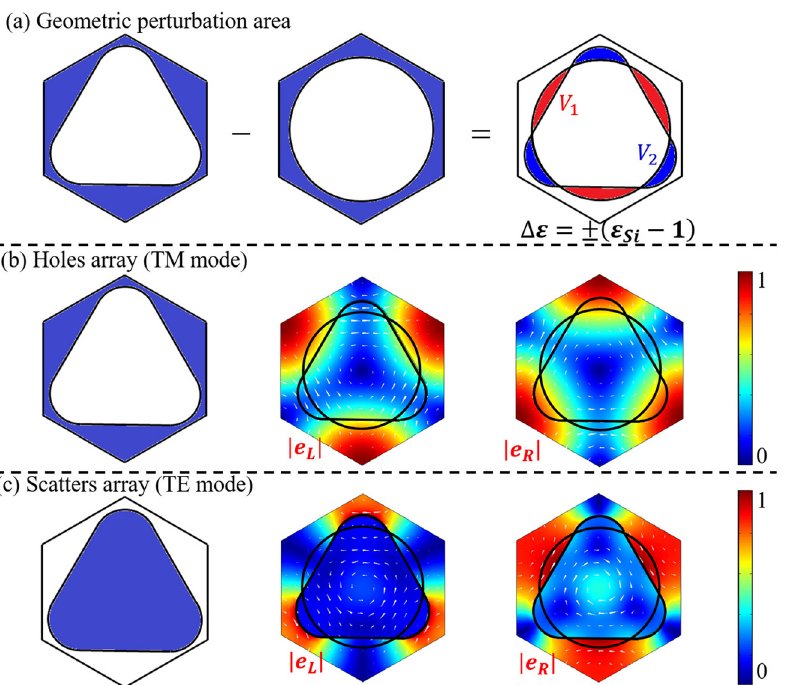
− 1 ) is Si 1 ( K ) is L,R